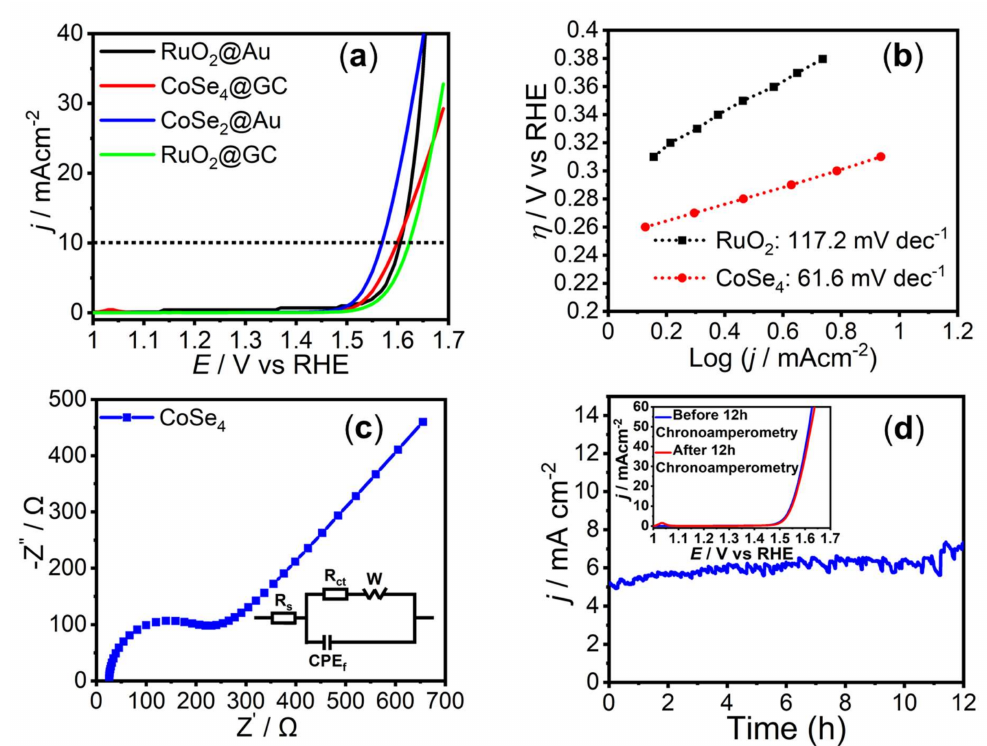
Figure 3. ( a ) LSV plots of OER for the CoSe 4 catalyst measured in N 2 -saturated 1.0 M KOH solution at a scan rate of 10 mV s − 1 . Dashed black line shows the current density of 10 mA cm − 2 . ( b ) Tafel plots of catalysts. ( c ) EIS spectra measured at 1.56 V vs. RHE in N2-saturated 1.0 M KOH solution over the frequency range of 1 MHz to 1 Hz. Inset shows the equivalent circuit where R s is the electrolyte resistance and R ct is the charge transfer resistance at the catalyst–electrolyte interface. ( d ) Stability study of CoSe 4 catalyst under continuous O 2 evolution for 12 h at 1.53 V. Inset shows the LSV plots of the CoSe 4 catalyst in N 2 saturated 1.0 M KOH before (blue) and after (red) chronoamperometry for 12 h. Table 1. Electrochemical parameters of the catalysts measured in 1 M NaOH. OER HER